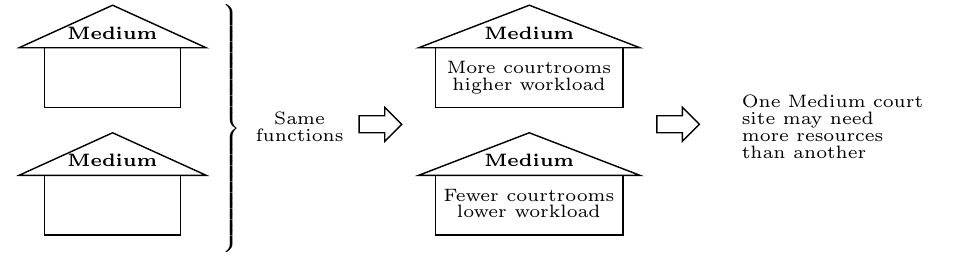
Figure 5: An illustration of the differences within one court